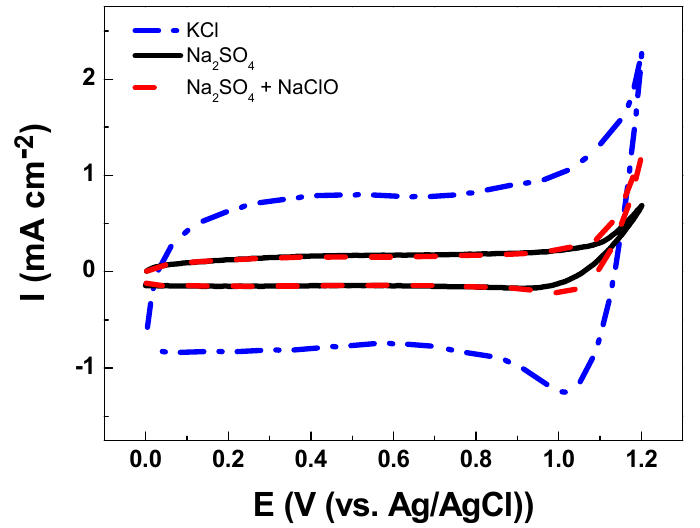
Figure 3. Cyclic voltammetry of Ti/RuO 2 -TiO 2 -SnO 2 (50:40:10 atom. %) as the working electrode at υ = 50 mVs -1 scan rate in ( --.-- ) 0.1 mol L -1 KCl solution, ( --- ) 0.033 mol L -1 Na 2 SO 4 solution, and ( -- -- ) 0.033 mol L -1 Na 2 SO 4 in the presence of NaClO 2.68 × 10 -3 mol L -1 at pH 7.0 and T = 24 °C.